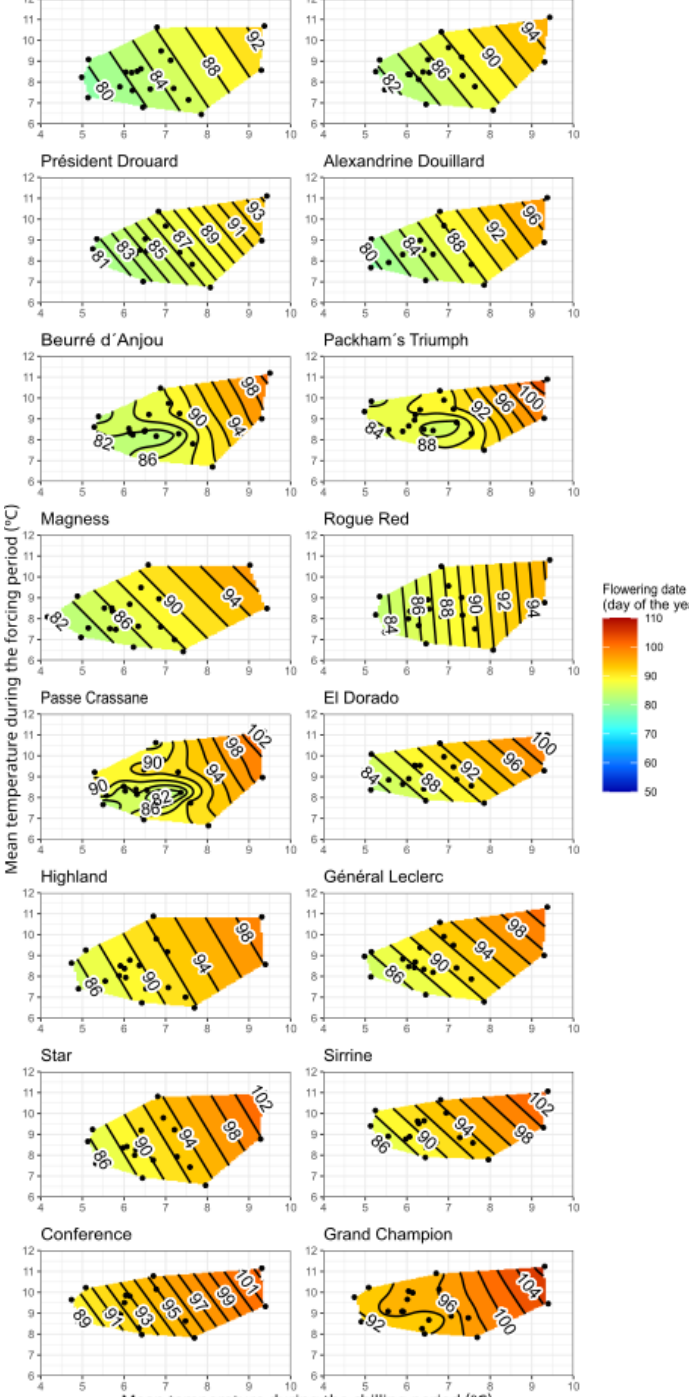
Figure 4. Flowering dates as a function of mean temperature during chilling and forcing periods as determined through PLS regression analysis of 20-year data for 16 pear cultivars grown in Zaragoza (Spain). The contour lines and the color surface show the expected flowering dates based on actual phenological data (black